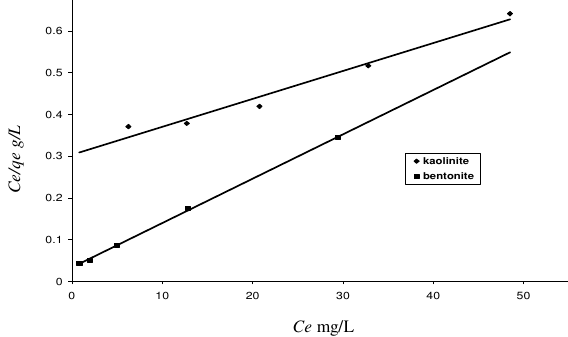
Figure 9. Langmuir adsorption isotherm for manganese(II)